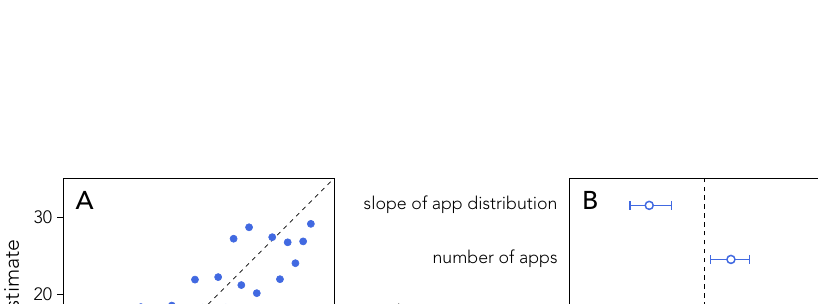
Figure 4. Identifying fingerprints across cultural contexts. ( A ) The average fraction of unique individuals within samples of 20,000 individuals from the same country, as a function of the number of apps n included in the fingerprint. Results are averaged across 240 samples, 20 for each of the months considered. Each line correspond to a different country. Countries in the legend are sorted based on the identification rate obtained for n = 5 , from highest to lowest. Re-identification rates are higher than in Fig. 2 as fingerprints are segmented into countries. ( B ) The standard deviation σ for the number of unique individuals across countries, as a function of the number of apps included in the fingerprint.